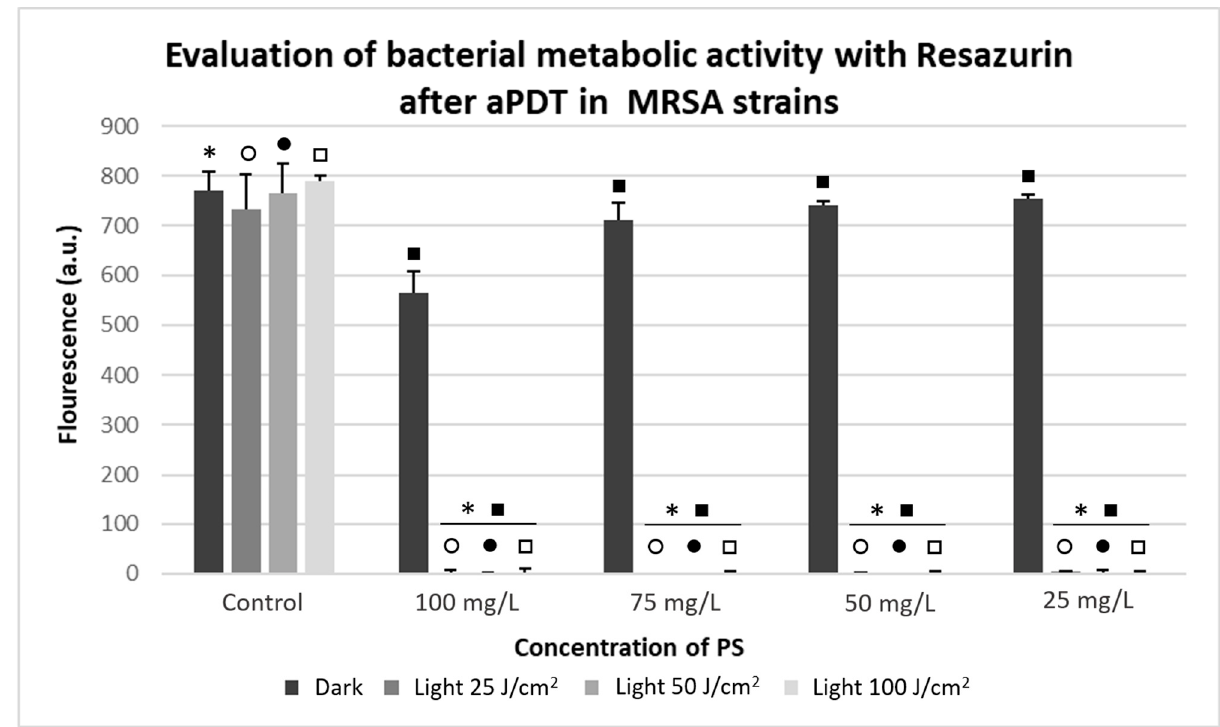
Figure 7. Evaluation of bacterial metabolic activity with Resazurin in arbitrary fluorescence units for MRSA strains, showing Dark and Light control groups, Photodithazine ® at 25, 50, 75, and 100 mg/L; and non-irradiated and irradiated groups with fluences of 25, 50, and 100 J/cm 2 . * Significant differences were observed between the Dark Control group to 100, 75, 50, and 25 mg/L with Dark, light 25, 50, and 100 J/cm 2 groups. ○ Significant differences were observed between the light 25 J/cm 2 Control group to 100, 75, 50, and 25 mg/L with light 25 J/cm 2 groups. ● Significant differences were observed between the light 50 J/cm 2 Control group to 100, 75, 50, and 25 mg/L with light 50 J/cm 2 groups. □ Significant differences were observed between the light 100 J/cm 2 Control group to 100, 75, 50, and 25 mg/L with light 100 J/cm 2 groups. ■ Significant differences were observed between the Dark 100, 75, 50, 25 mg/L groups to 100, 75, 50, and 25 mg/L with light 100, 75, 50, and 25 J/cm 2 groups.